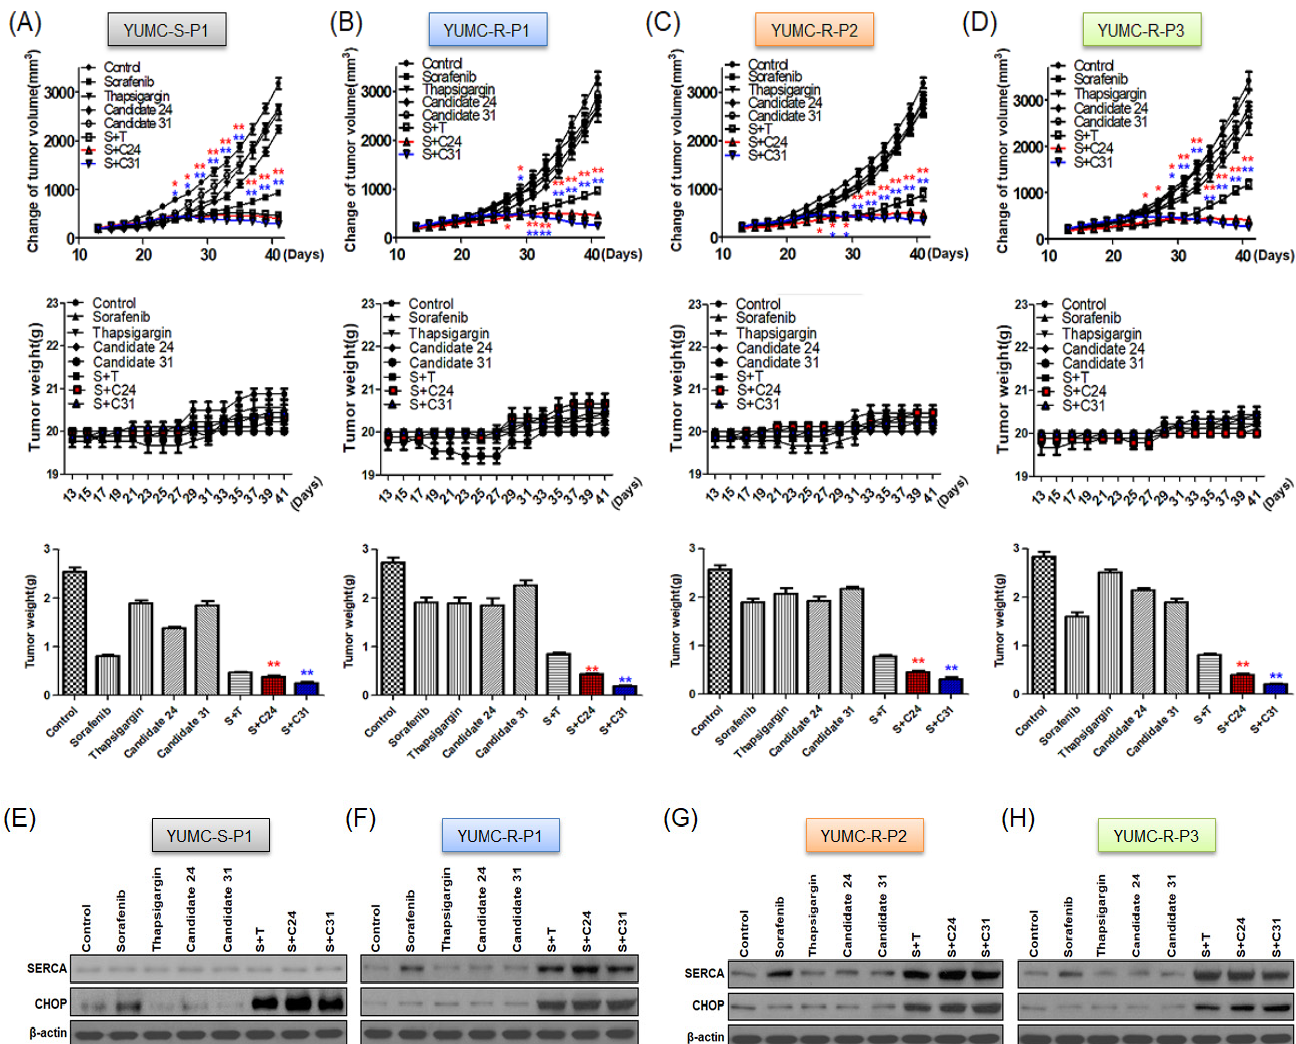
Figure 4. Combined therapy of sorafenib and novel SERCA inhibitors increased tumor shrinkage more effectively in human sorafenib-resistant PTC cells (YUMC-R-P1, -P2, and -P3) than in a human sorafenib-sensitive (YUMC-S-P1) xenograft model. (( A – D ), top ) Changes in tumor volume, (( A – D ), middle) Changes in whole-body weight, and (( A – D ), bottom ) the resected tumor weight (each group, n = 10). Tumor size was estimated in NOD/Shi-scid IL-2R γ KOJic (NOG) mice, where animals were presented with each agent alone or with either sorafenib joined with novel SERCA inhibitors (candidates 24 or 31). ( E – H ) Immunoblot analysis with SERCA and CHOP (endoplasmic reticulum stress marker) in a mouse xenograft model with sorafenib-sensitive (YUMC-S-P1) and -resistant (YUMC-R-P1, -P2, and -P3) PTC cells. Data symbolize the mean ± standard error of the mean. * p < 0.05 and ** p < 0.01, compared to the control. *; C24 and *; C31.